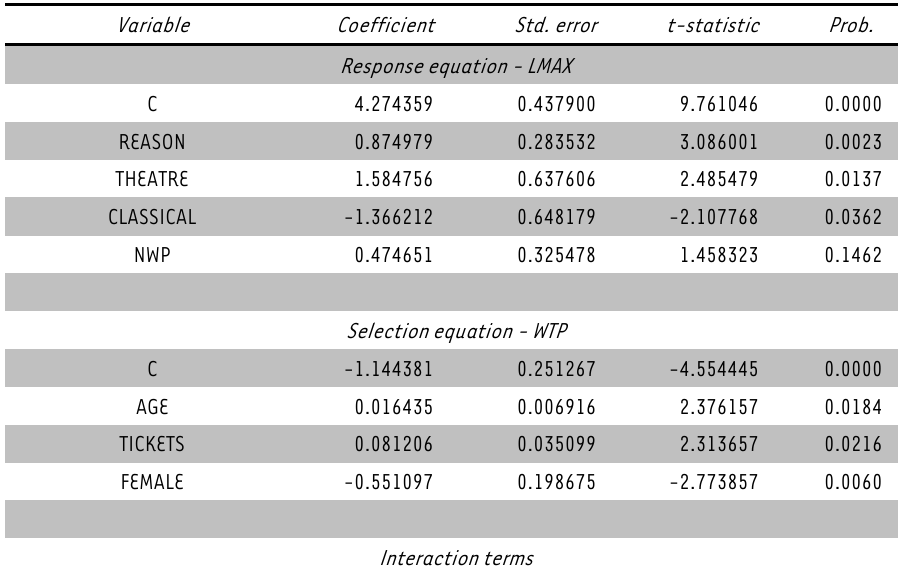
Results of the Heckman